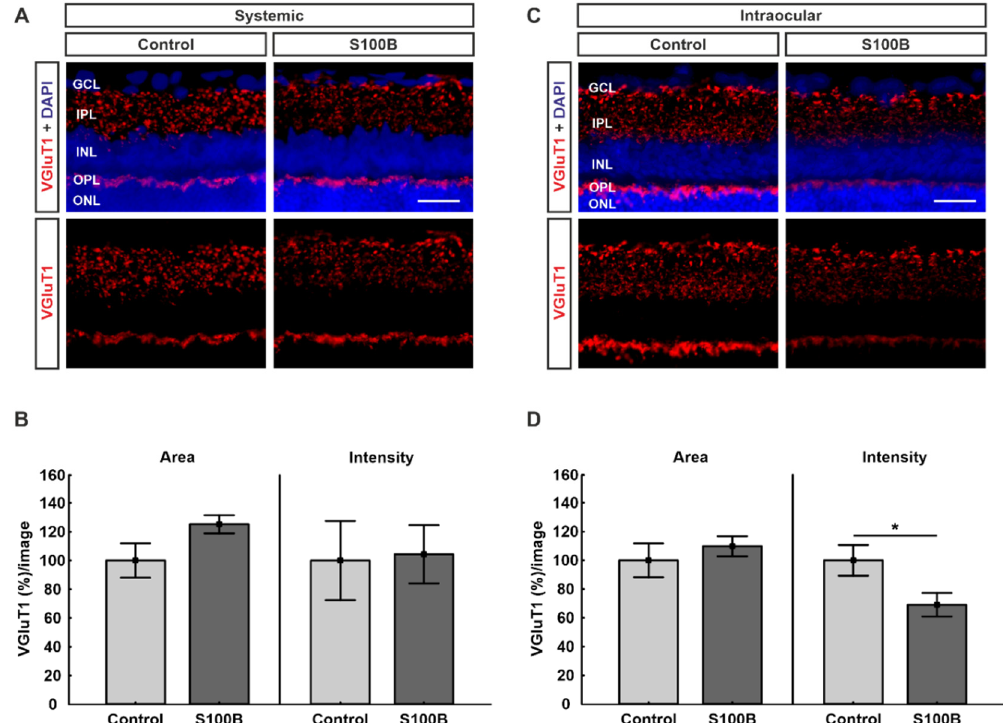
Figure 5. Remodeled VGluT1 in intraocular-injected animals. ( A ) Retinas from animals with systemic immunization ( n = 7/group) were labeled against VGluT1 (red). Cell nuclei were labeled with DAPI (blue). ( B ) The statistical evaluation of the VGLUT1-stained area showed no significant difference between both groups, though there was a trend towards greater signal area in the S100B group ( p = 0.08). The intensity of the staining remained unchanged ( p = 0.90). ( C ) Retinas from animals with intraocular application ( n = 7/group) were labeled against VGluT1 (red). DAPI visualized cell nuclei (blue). ( D ) The evaluation of the percentage of labeled area revealed no alterations between both groups ( p = 0.48). In comparison to controls, the intensity of the staining in the S100B group was significantly lower ( p = 0.04). Abbreviations: GCL: ganglion cell layer; IPL: inner plexiform layer; INL: inner nuclear layer; OPL: outer plexiform layer; ONL: outer nuclear layer. Scale bar: 20 µm. Values are mean ± SEM. * p < 0.05.